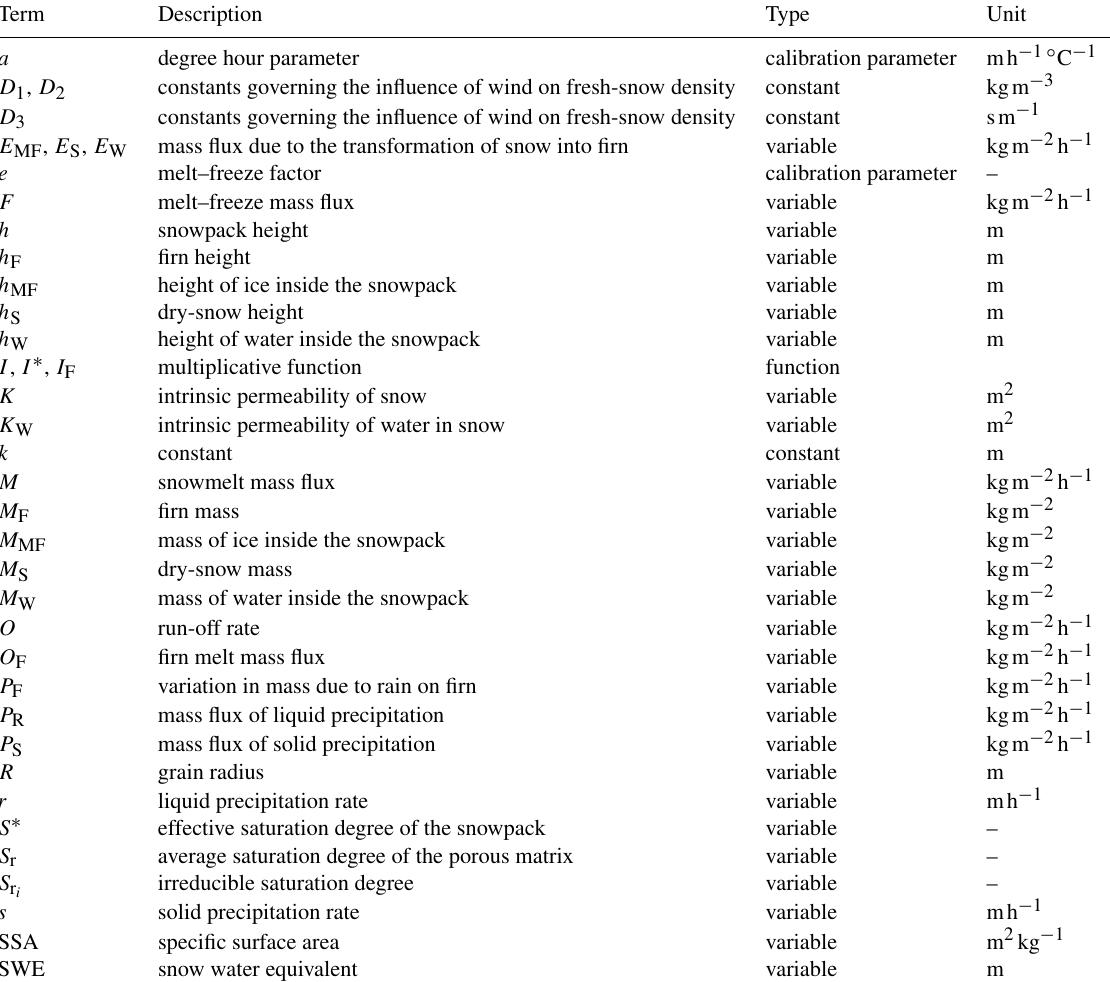
Table B1. List of the symbols and abbreviations used in the mass fluxes of the snow–firn model with the exclusion of snow erosion (from A to